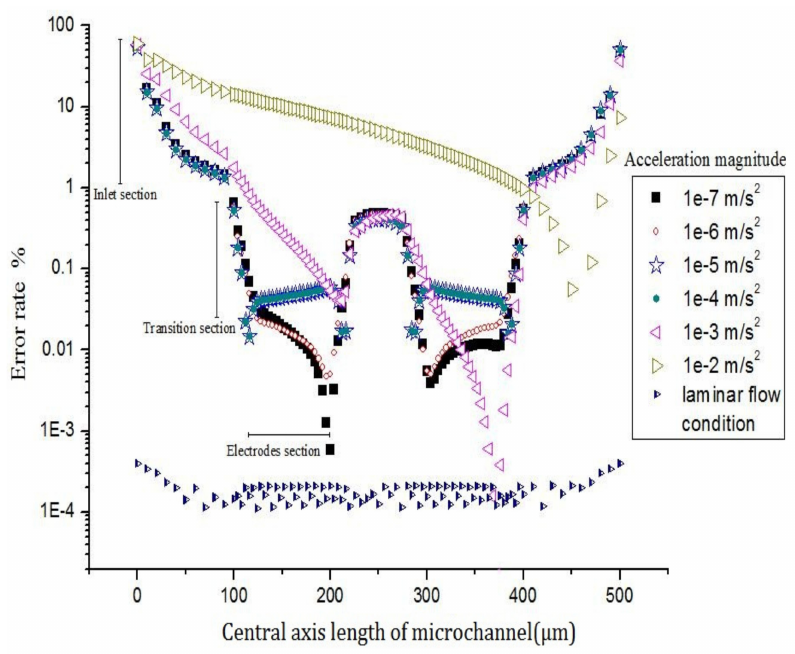
Figure 8. Error rate of central axis velocity in sensing